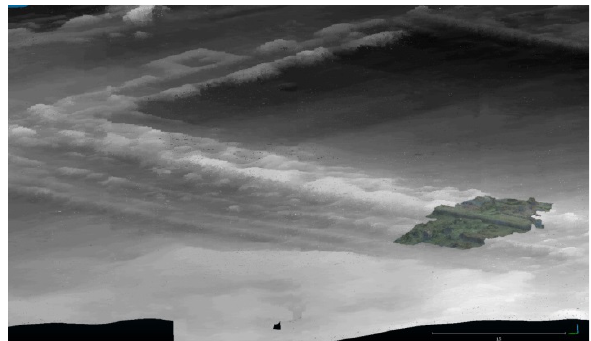
Figure 5. Opto-acoustic alignment of the Villa Pisoni.